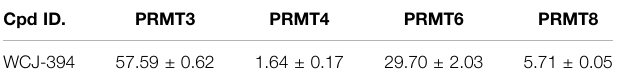
TABLE 4 | Inhibitory activities (IC 50 , μ M) of compound WCJ-394 against type I PRMTs. Cpd ID.